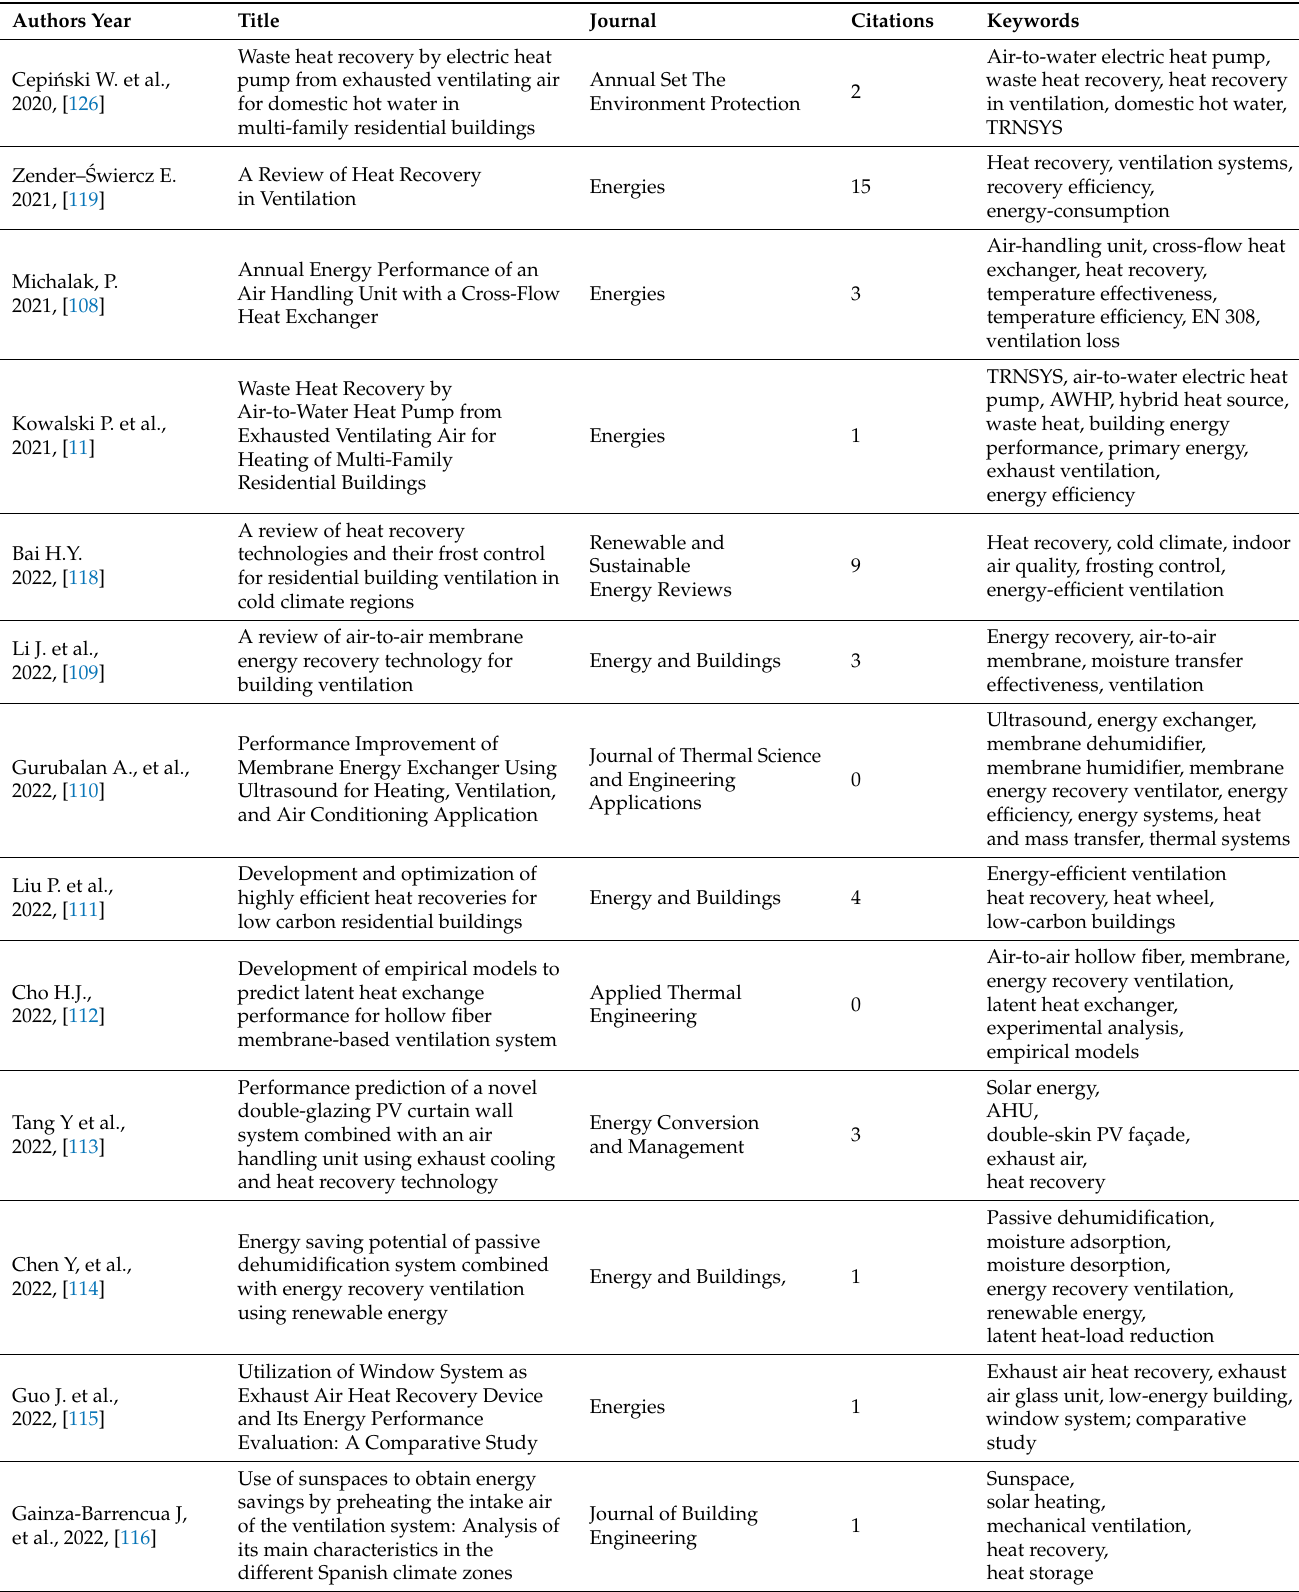
Table 6. Reviewed papers on heat recovery from exhausted